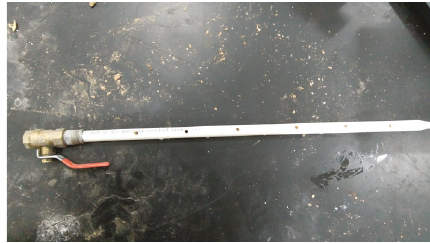
Figure 3: Sketch map of grouting mesh holes.